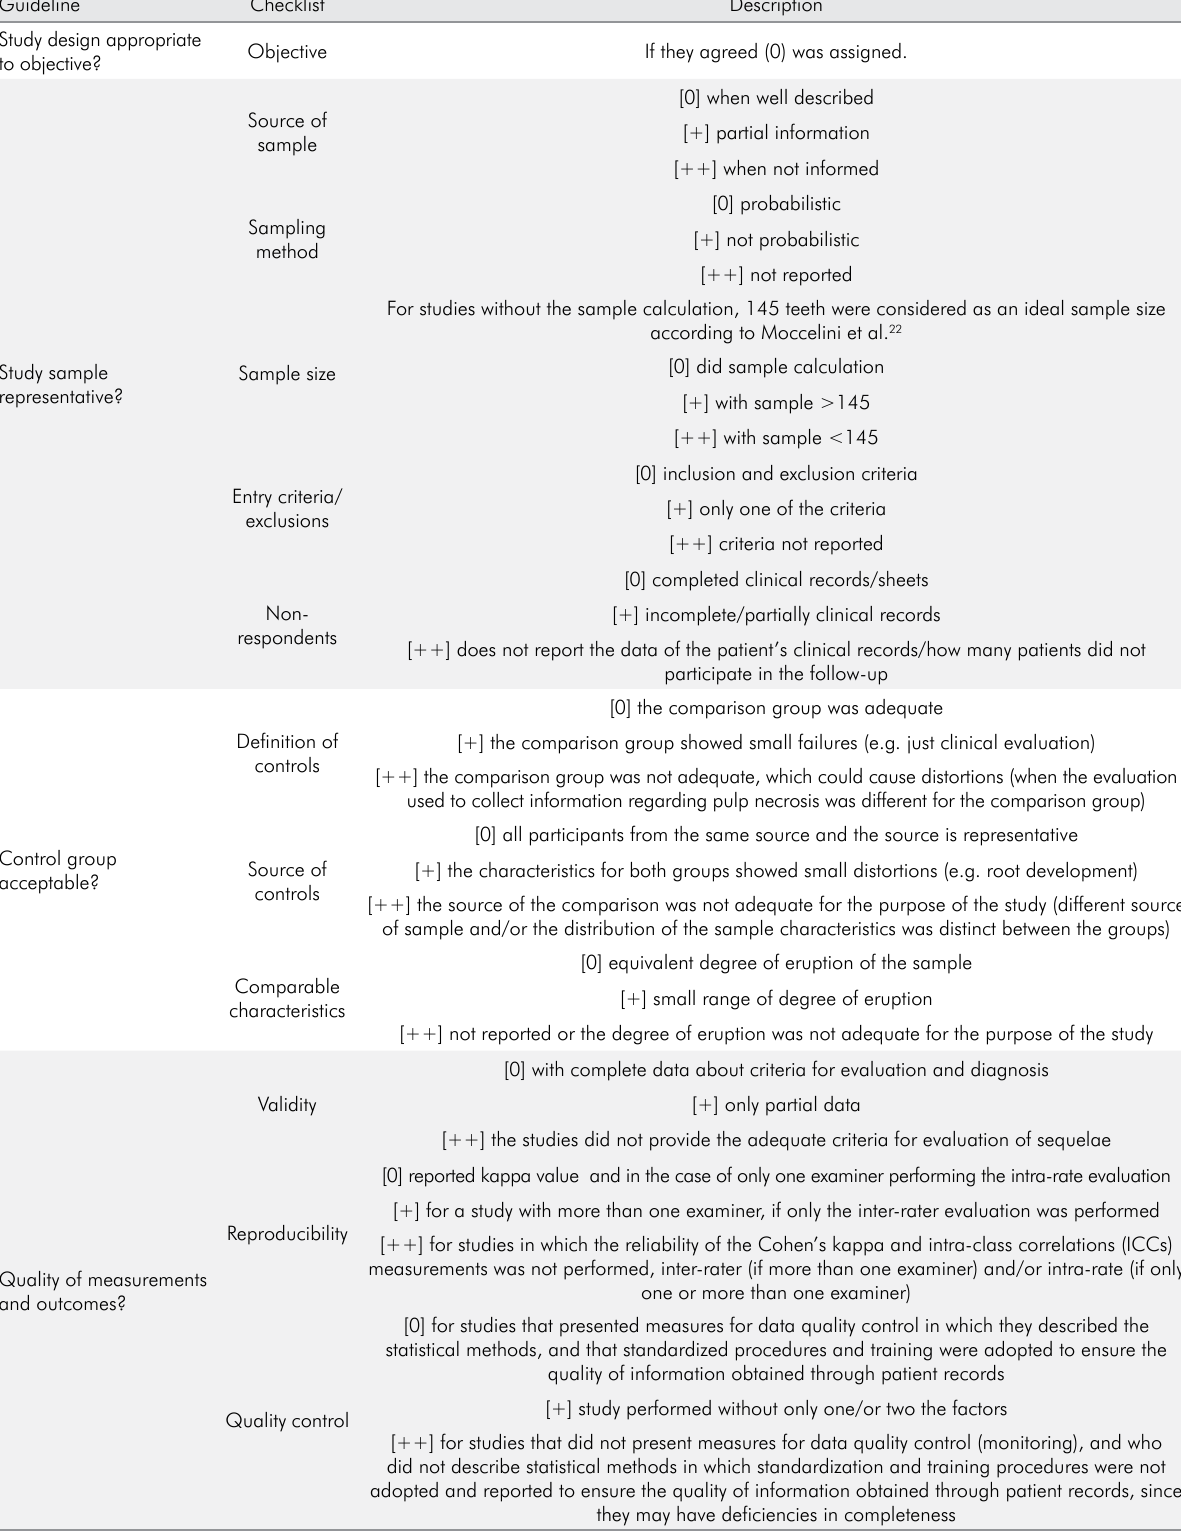
Table 2. Domains and Risk of Bias considered in accordance with the items of the guidelines and critical appraisal described by Fowkes and Fulton.